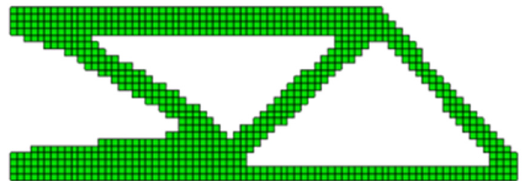
Figure 11. Solution of the reference problem solved with a BESO algorithm for isotropic materials.